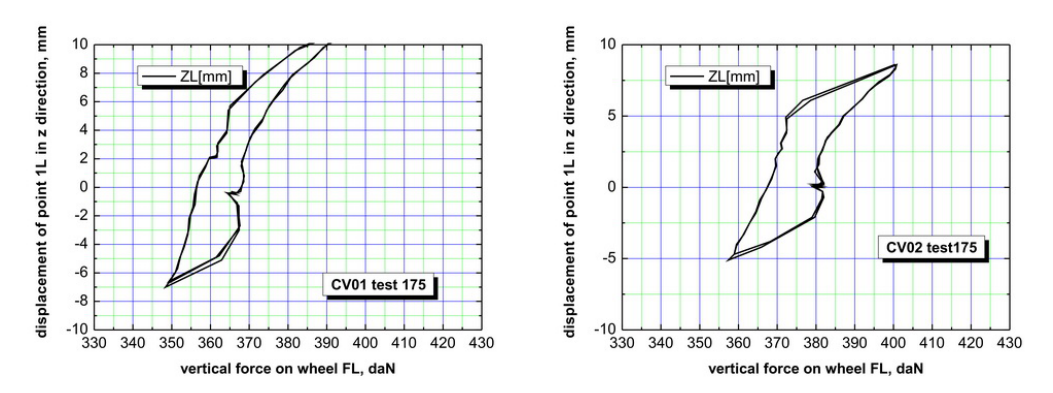
Fig. 5.8. Displacement alterations depending on vertical force during test No.175 – vehicle 01.